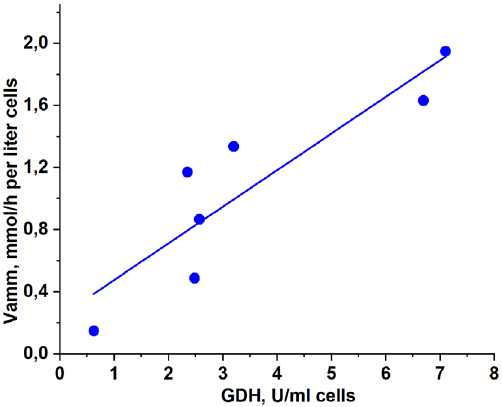
Figure 6. Dependence of the ammonium consumption rate in the suspension of ammocytes on the GDH activity. Suspension hematocrit 23%, temperature 25 °C, 1 mM NH 4 Cl and 10 mM PYR added. The ALT activity in all experiments was 2–3 times higher than the corresponding GDH